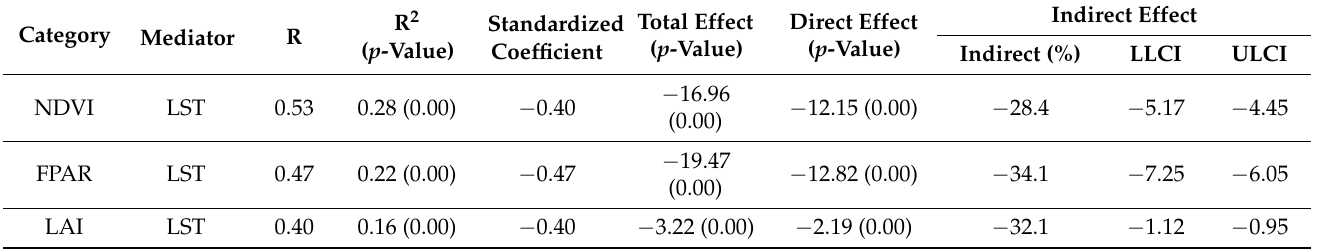
Table 6. Mediation analysis results between NDVI, fraction of FPAR, LAI, and LST on GOSAT XCO 2